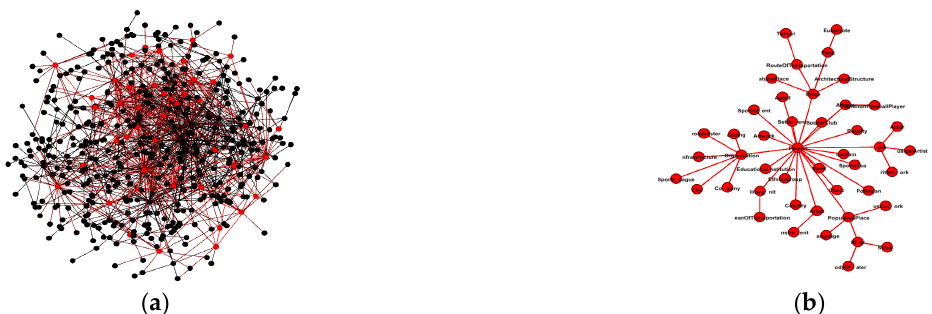
Figure 1. The DBpedia v3.8 schema graph ( a ) and a corresponding schema summary ( b ).